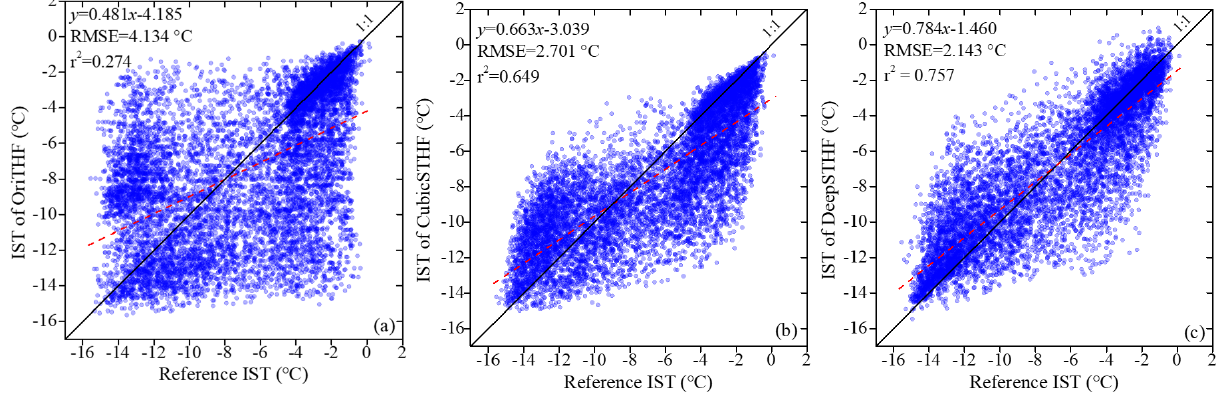
Figure 7. Scatter plots of the reference IST in lead areas obtained from the Landsat and the IST obtained by a different method. (a) The OriTHF method; (b) the CubicSTHF method; (c) the proposed DeepSTHF method. The red dashed lines denote fitted linear regression lines of the data points; RMSE and r denote the root-mean-square error and Pearson coefficient,